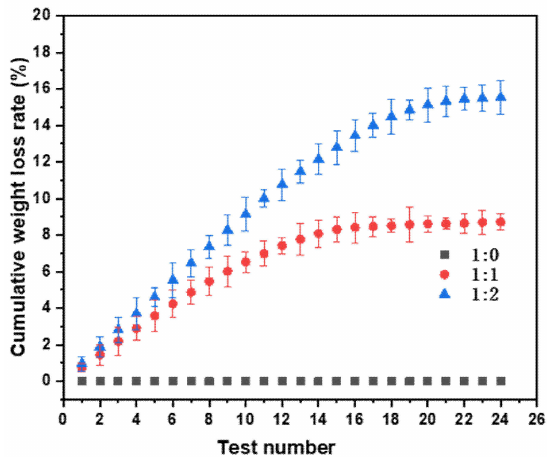
Figure 4. The cumulative weight loss rate values of di ff erent samples after di ff erent test numbers in the oil replenishment / loss cycle